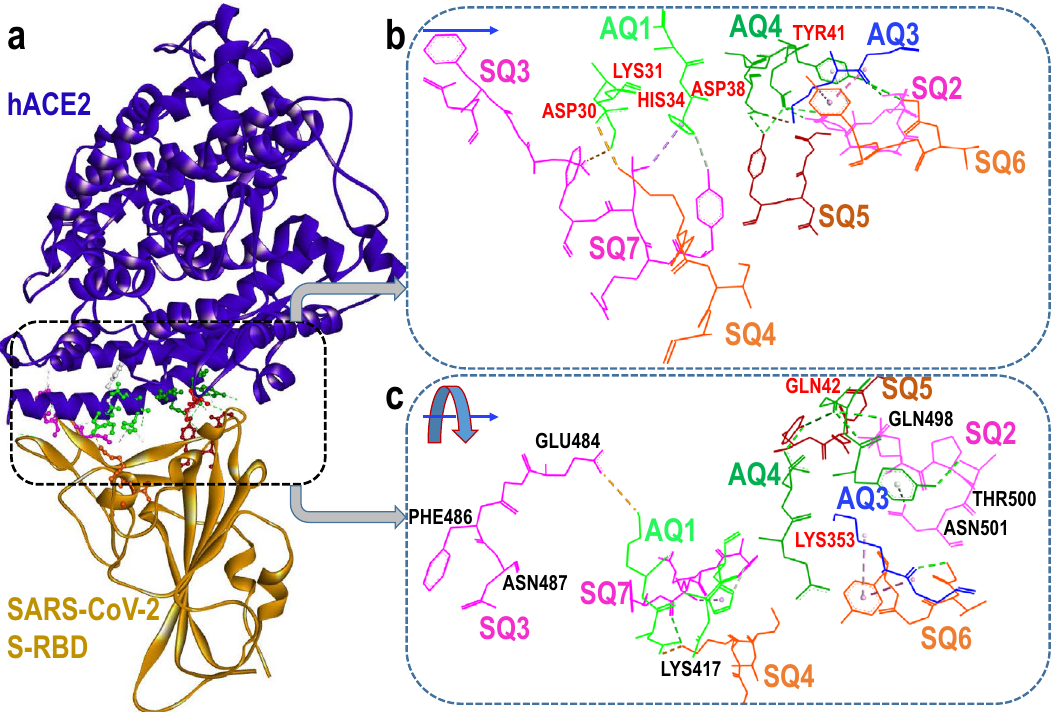
Figure 1. Identification of main attractive four-residue fragments ( quartets ) of the spike (S) protein from SARS-CoV-2 and the human (h) receptor ACE2. ( a ) Structure of the prefusion conformation of the viral spike (S) protein (shown in gold) in contact with the human angiotensin-converting enzyme 2 (hACE2) (shown in blue) 14 . The spike protein receptor binding domain (S-RBD) makes contact with hACE2 residues. The hACE2- S-RBD interface is enclosed in the dashed box and some four-residue (i.e quartet ) fragments, which promote host-virus attraction, are shown. ( b ) Magnified view of three hACE2 quartets , AQ1, AQ3 and AQ4 , involved in significant attractive interactions with the S-RBD. Six S-RBD quartets , SQ2, SQ3, SQ4, SQ5, SQ6 and SQ7 , displaying attractive character towards hACE2 are also shown. A rotated view is presented in ( c ). Labels of selected attractive residues corresponding to hACE2 (in red) and the S-RBD (in black) are included. All constituent residues of each quartet are listed in Tables 1,